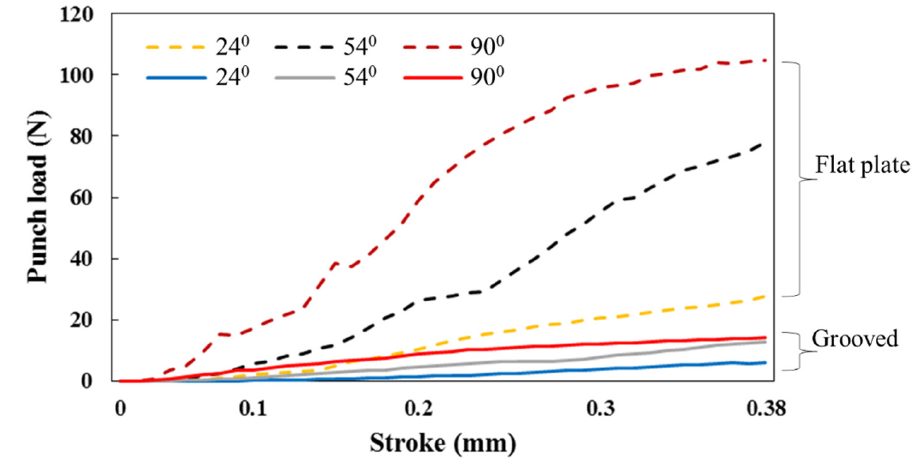
Figure 5. Relationship between stamping depth (stroke) and punch load.